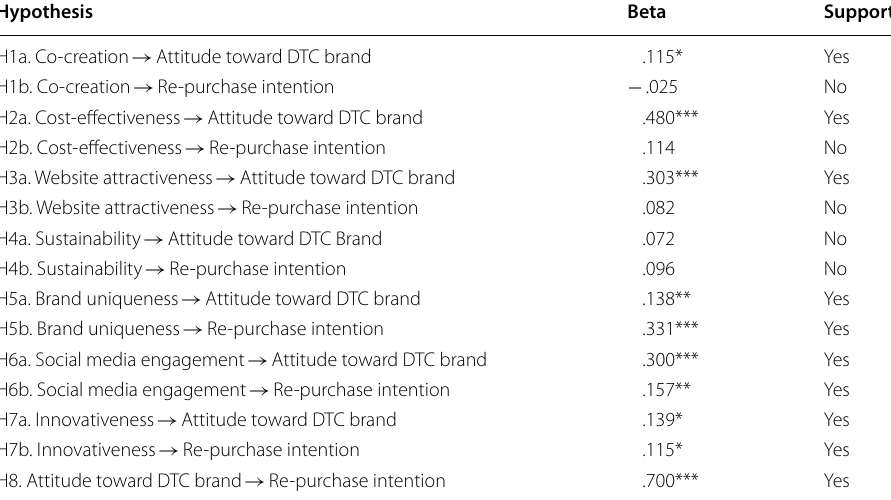
Table 5 Results of the Hypothesis Testing